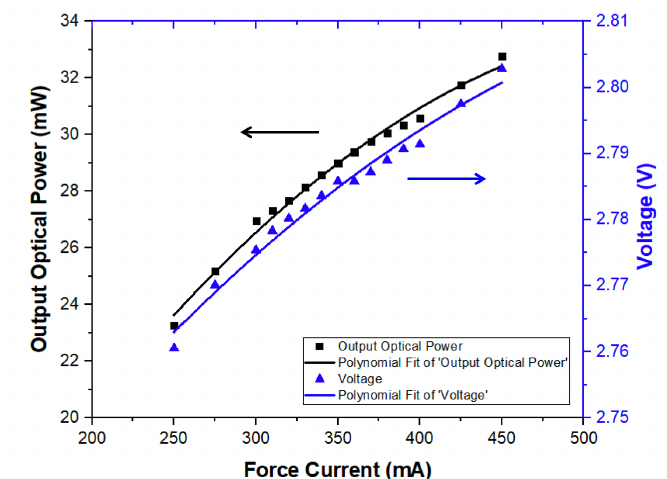
Figure 7. Average P-I-V curve of 7 LED